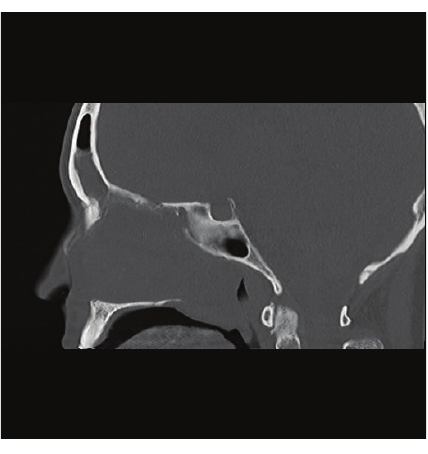
Figure 3: CT (sagittal view bone window).